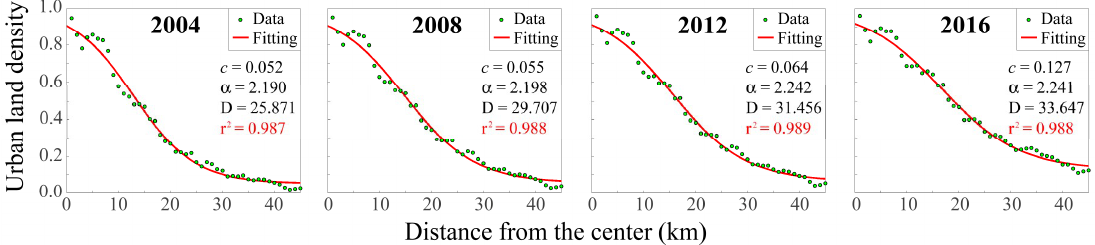
Figure 5. Fitting of the land density data with the inverse S-shape function (Equation (1)) and corresponding parameters c , α, and D . The coefficient of determination r 2 is reported.